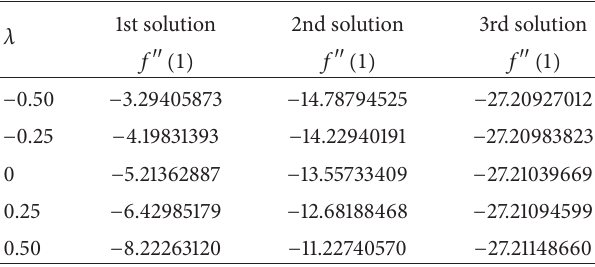
Table 1: Skin friction for different values of buoyancy